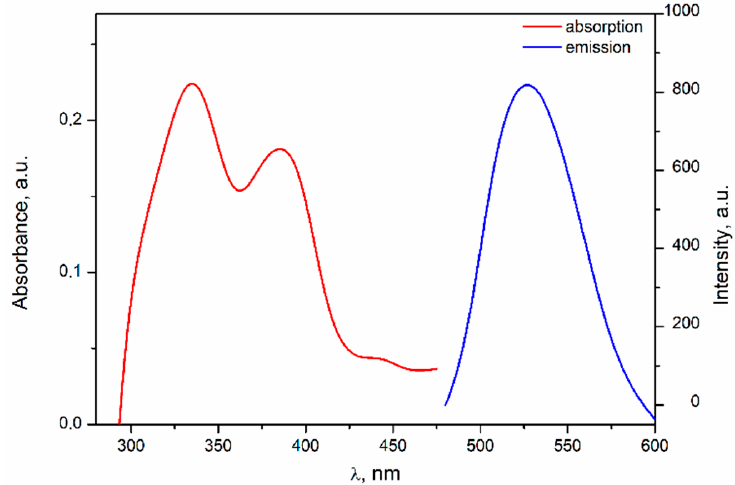
Figure 11. Solid state UV-Vis absorption and emission spectra of complex 7 .